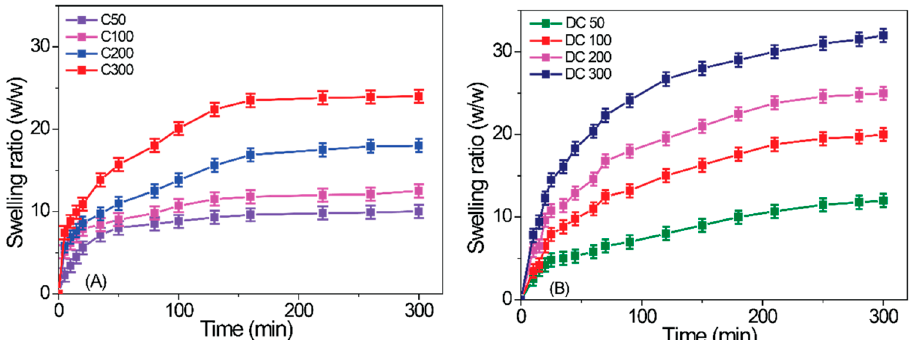
Figure 5. Variation of swelling ratio with time for different carbohydrate-based gels: ( A ) organogels in dichloromethane (DCM) and ( B ) hydrogels in aqueous medium (pH 6.8).